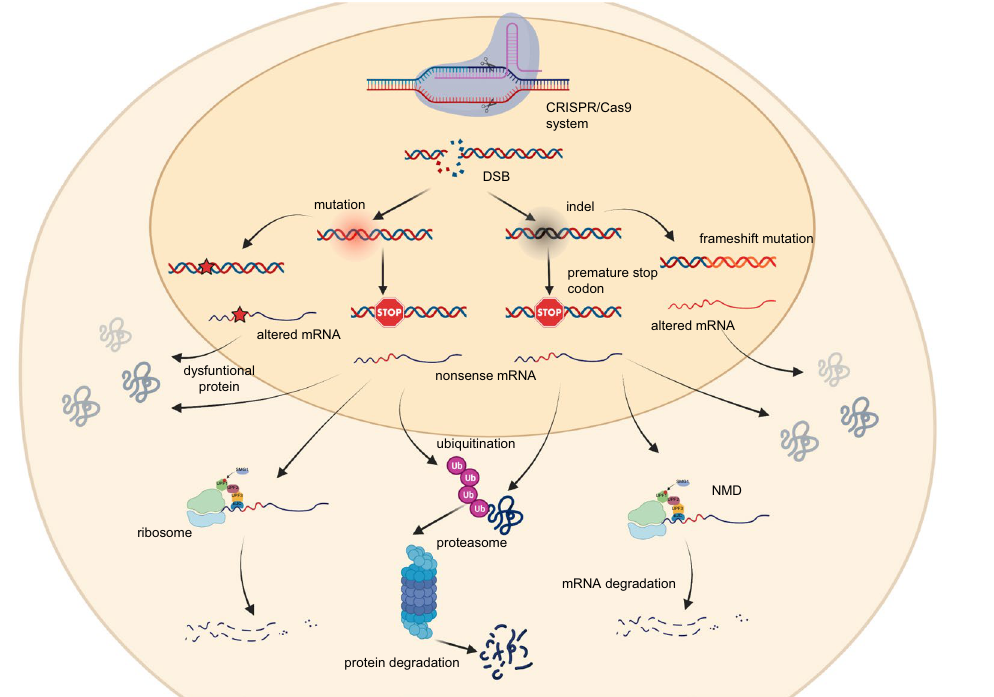
Figure 9. Cellular mechanisms activated following DSB. Following the creation of the DSB in the cleavage site by the RNP complex, the cell activates two possible mechanisms in order to repair the double helix: homologous recombination (HR) and non-homologous end-joining (NHEJ). The latter is activated more frequently than HR, and, being an error-prone mechanism, can cause the introduction of indels or mutations in the target gene. In the first case, if the indels are multiples of three, an in-frame mutation is created with the addition of one or more aminoacids that can alter the characteristics of the protein, such as reducing its functionality or its stability. Conversely, if the indels are not multiples of three, a frameshift mutation is introduced with the establishment of a premature stop codon. The nonsense transcript produced can face two fates: if it is recognized by the nonsense mediated decay (NMD) it is degraded, otherwise it is translated into a truncated protein, which in most cases is ubiquitinated and degraded by proteasome. In the case of the introduction of point mutations, these can be silent, for example in the case they concern the third nucleotide of a codon—nonsense, when they establish a premature stop codon—or missense, in the case they determine the change of an aminoacid. Nonsense mutations can be recognized by NMD with consequent degradation of the transcript or give rise to truncated proteins, while missense mutations can cause the production of an altered protein (created with BioRender.